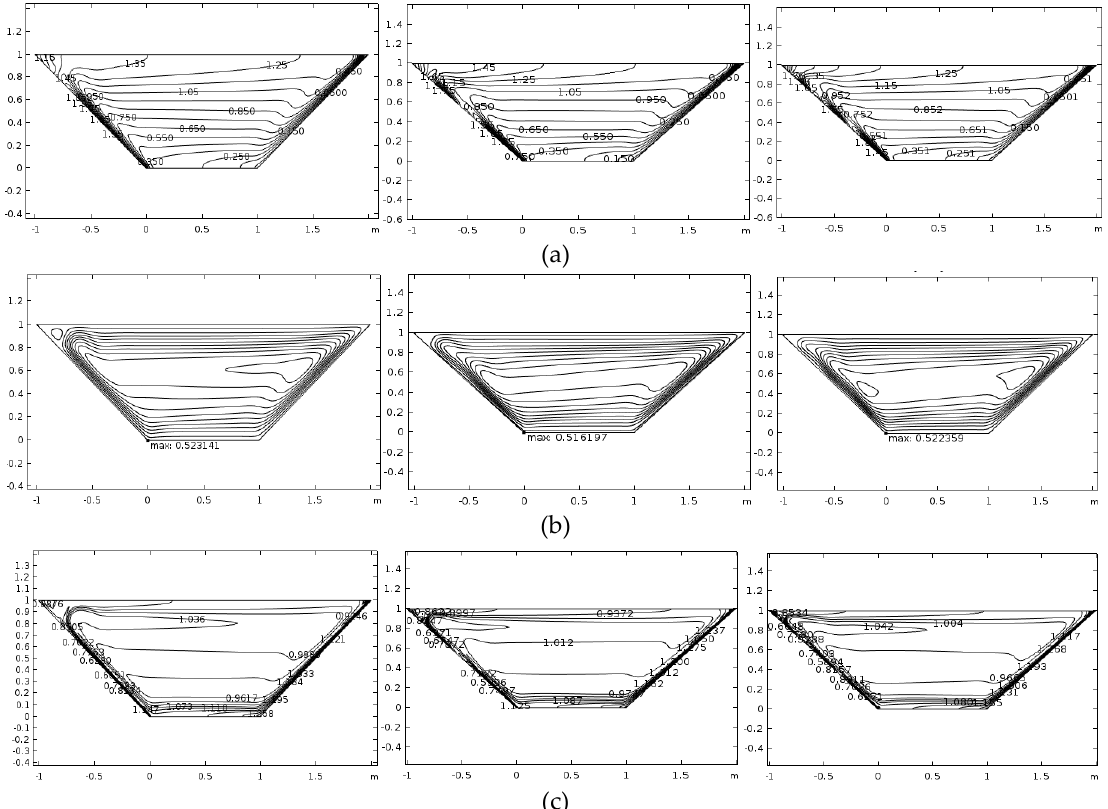
Figure 5. Isotherms, streamlines, and isoconcentrations for Ra = 10 6 , Pr = 7, ϕ = π / 4, ε = 0.5, and various quantities of wave parameter ( a ) κ = 1, ( b ) κ = 2, ( c ) κ = 3.